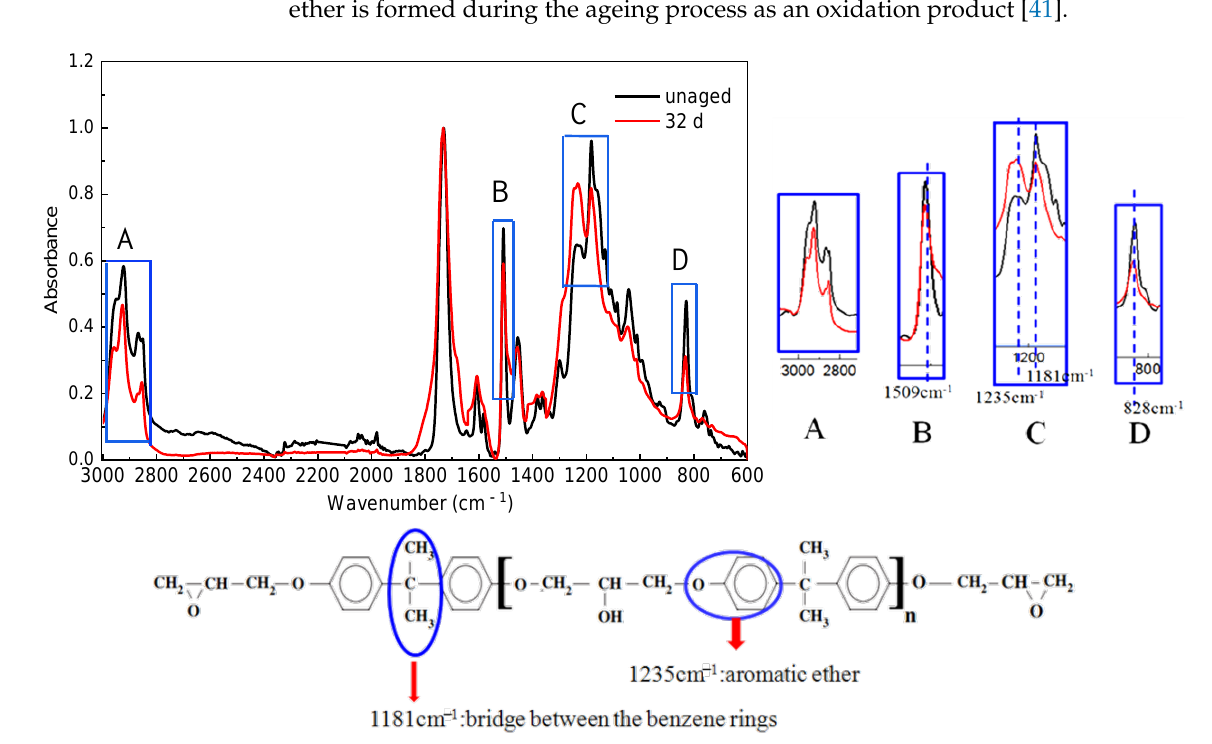
Figure 6. IR spectra of the un-aged resin and the surface of an epoxy cube after ageing at 180 °C for 32 days.